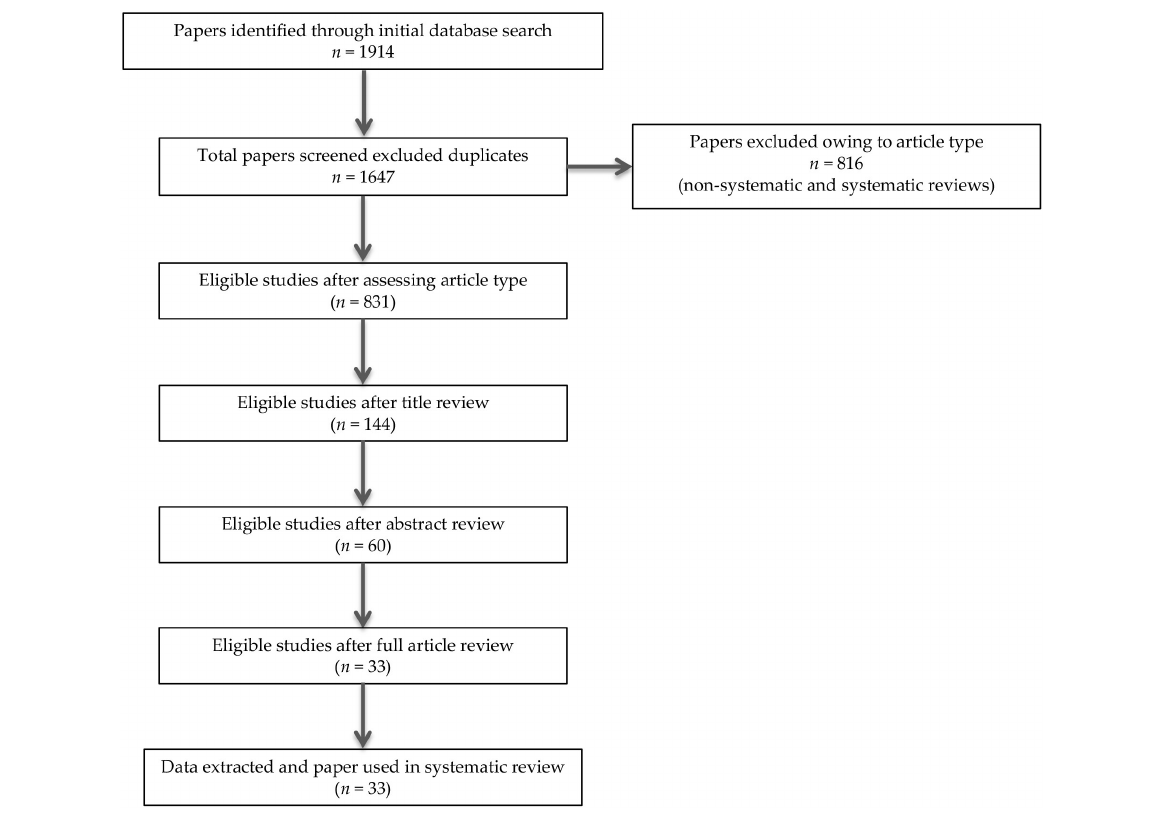
FIGURE1 PRISMA flowchart of search strategy for systematic review.